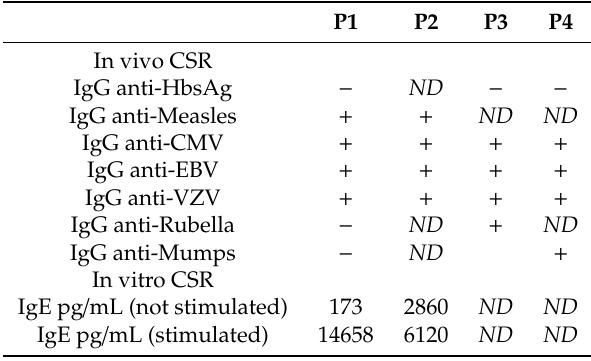
Table 3. In vivo and in vitro class switch recombination (CSR).